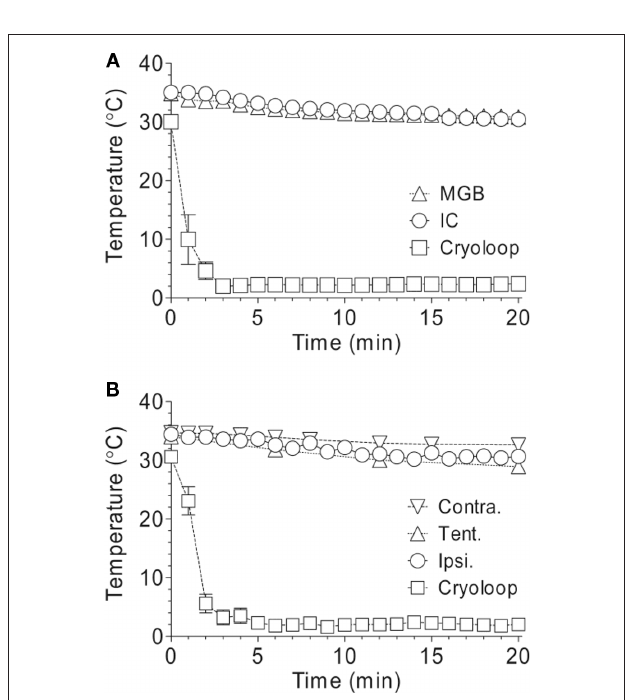
Figure 5 | Temperature recorded depth-wise across the span of auditory cortex in the center of the loop for two gPs during cooling (surface to 2 ° C), illustrating the presence of thermoclines in auditory cortex.